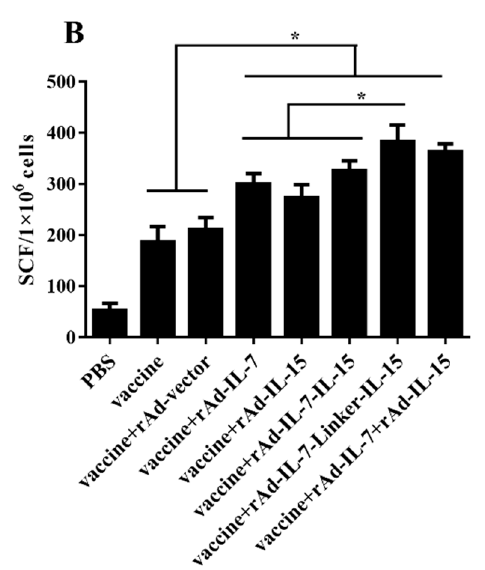
Figure 1. Cultured ELISPOT assay for antigen specific T CM like cells. At 20 weeks after the last vaccination, lymphocytes of mice were cultured with or without a cocktail of antigens ESAT-6, Ag85B, Rv2626c and HspX for 9 days. Then, cells were re-stimulated with the same antigens for 20 h. ( A ) Representative images of IFN- γ ELISPOT wells from long-term cultured ELISPOT assays at 5 × magnification. ( B ) Results of long-term cultured ELISPOT responses assay. Data were presented as means ± SD from groups of 4 mice. * p < 0.05.